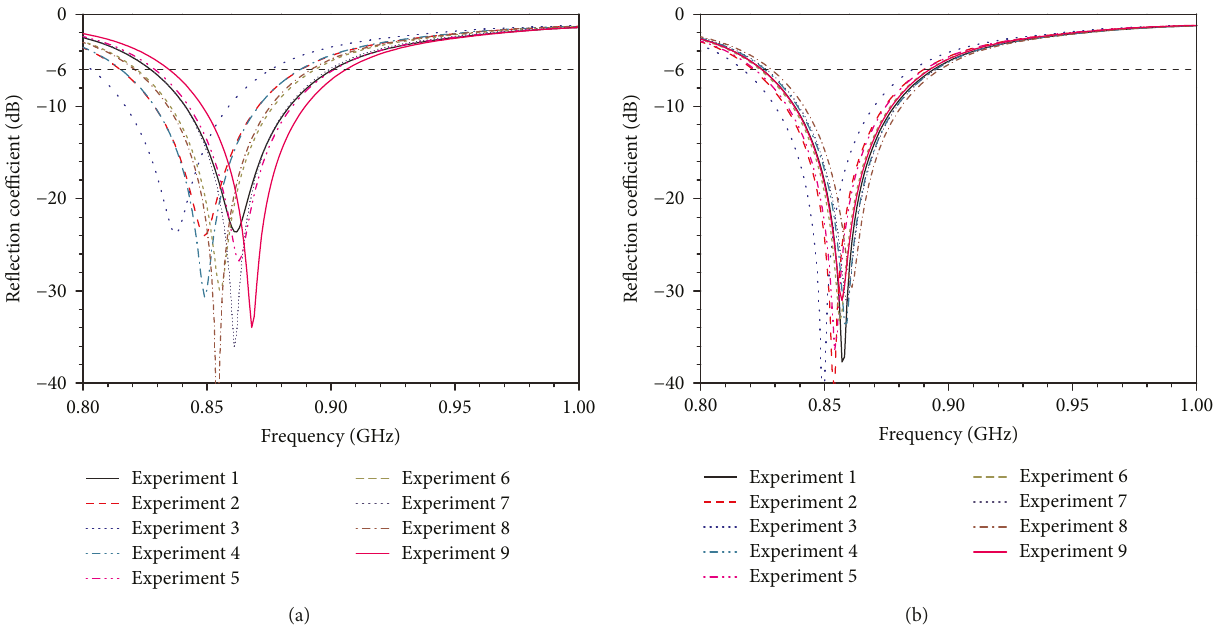
Figure 8: Simulated re fl ection coe ffi cients of the antenna using the experimental parameters listed in (a) Table 3 and (b) Table 4.